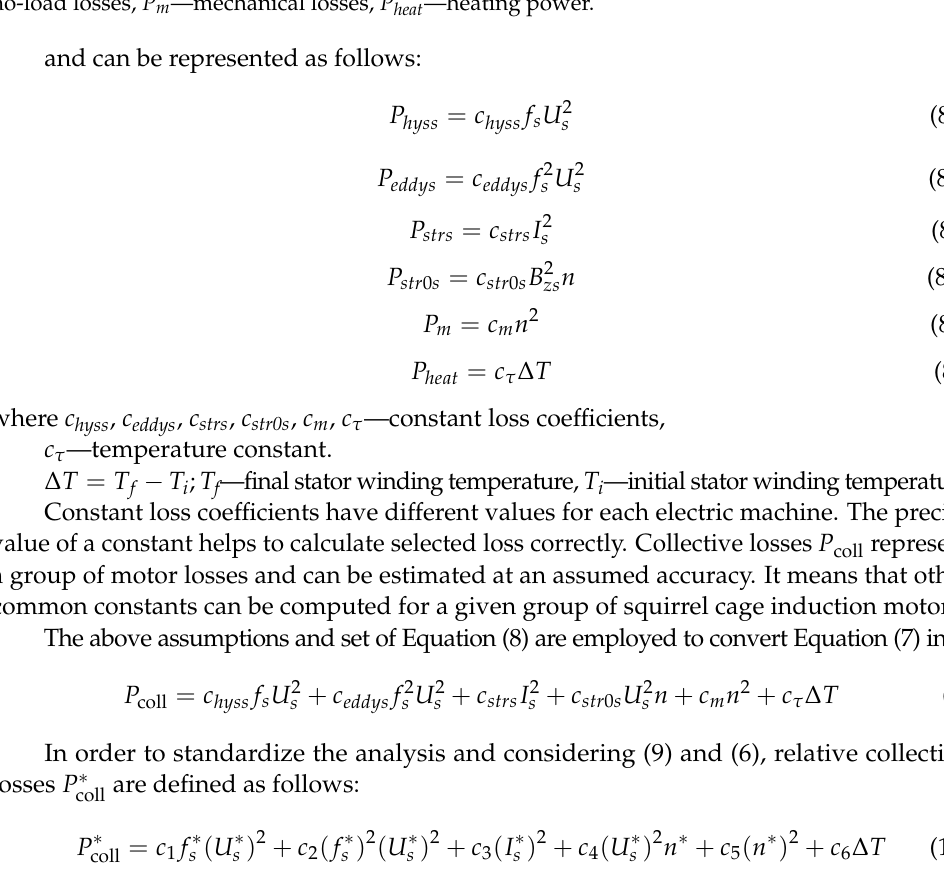
Figure 3. A block diagram showing parts of collective losses P coll , P cor —core losses, P hyss —stator hysteresis losses, P eddys stator eddy-current losses, P strs —stator stray load losses, P str0s —stator stray no-load losses, P m —mechanical losses, P heat —heating